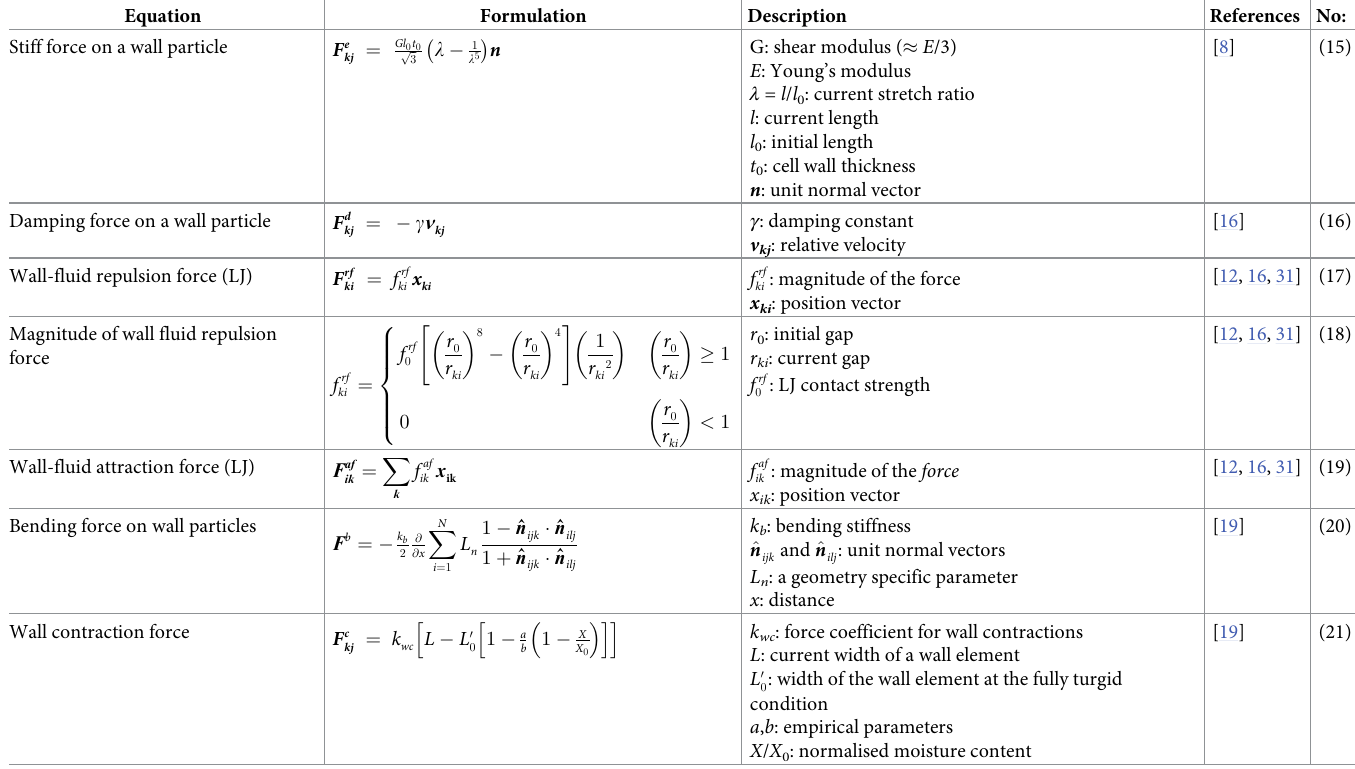
Table 2. Governing equations and corresponding formulae for the wall particle scheme. Equation Formulation Description References